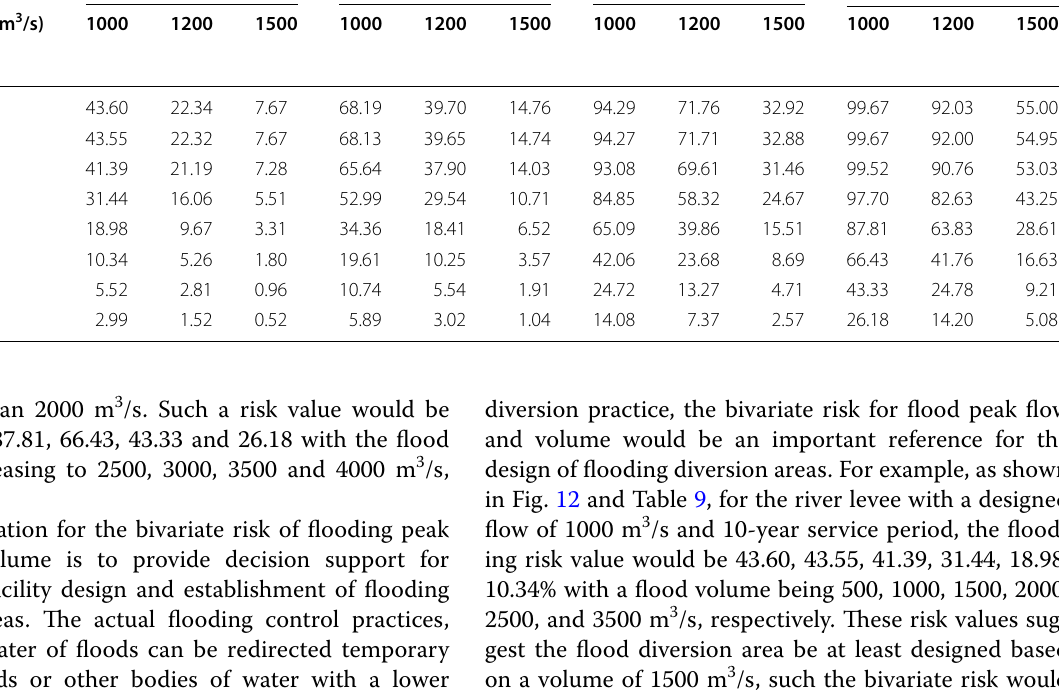
Table 9 The flooding risks in Xiangxi river under different peak-volume scenarios (%) Service time 10 years 20 years Designed flow (m 3